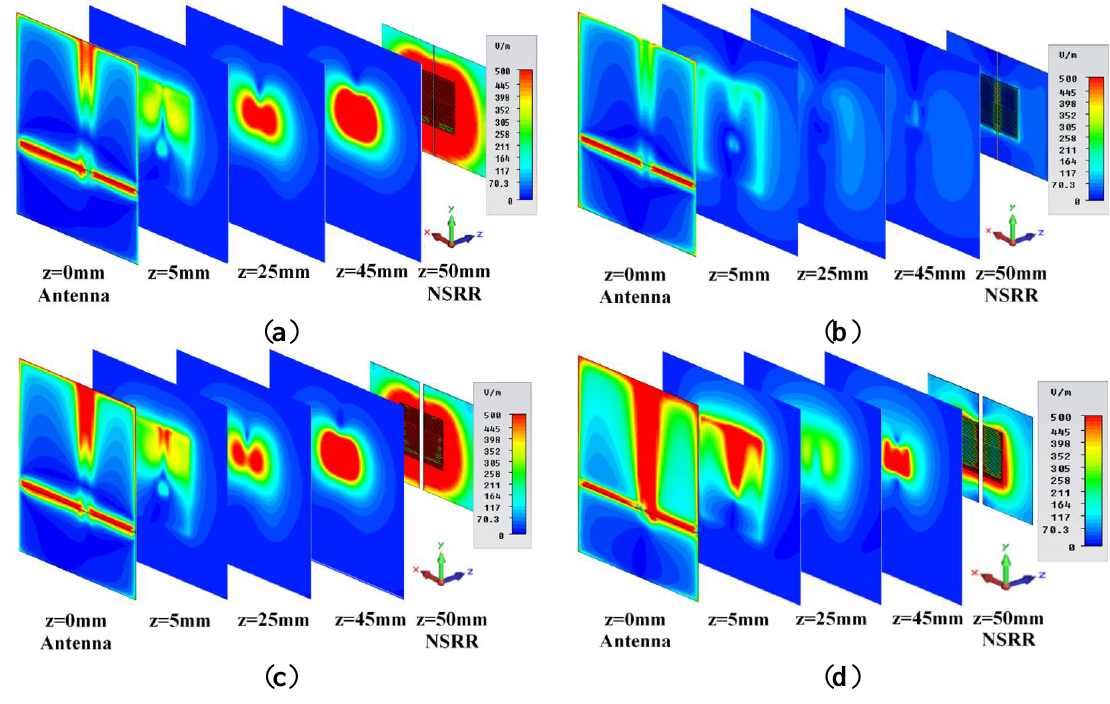
Figure 2. ( a ) Electric field map numerically calculated on the antenna on the 1-mm-separated NSRR probe, and at several cross-sections between the antenna and the probe when the simulation frequency is the resonance frequency of d = 1 mm (406 MHz); and ( b ) when d = 1 mm again but the simulation frequency is 448 MHz (off-resonance case for d = 1 mm); ( c ) Electric field map on the antenna, on the 5-mm-separated NSRR probe and at several cross-sections between the antenna and the probe when the simulation frequency is the resonance frequency of d = 5 mm (448 MHz); and ( d ) when d = 5 mm again but the simulation frequency is 406 MHz (off-resonance case for d = 5